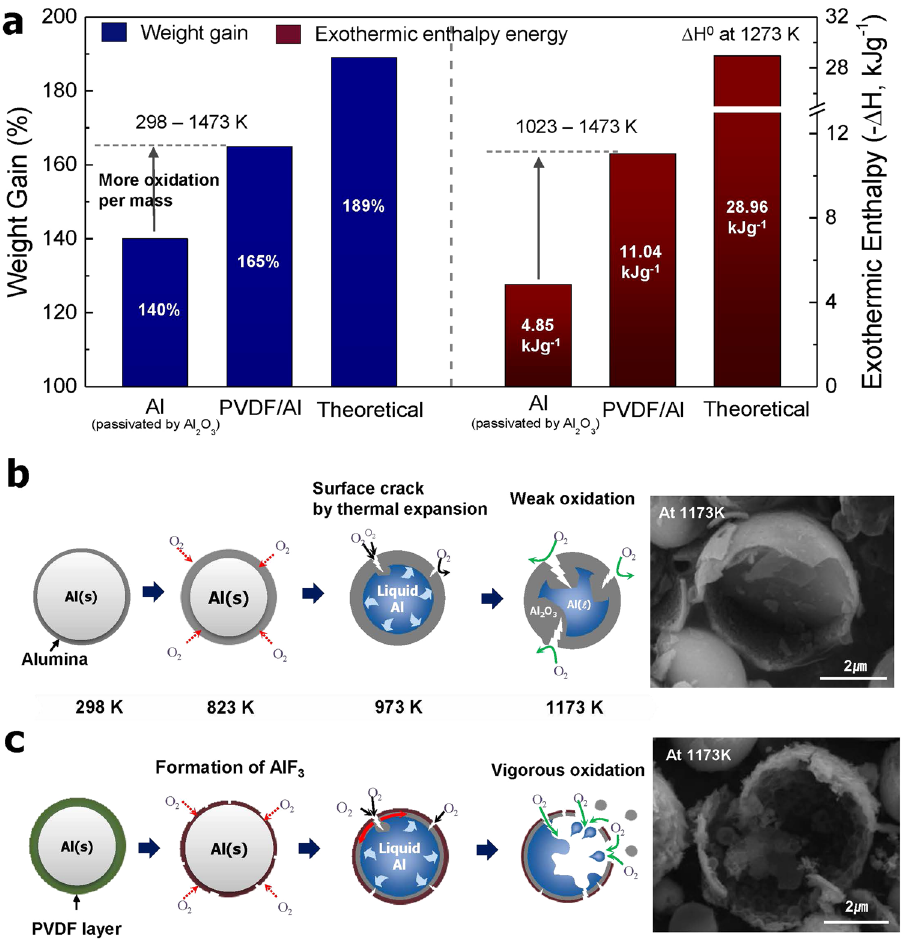
Figure 5. ( a ) Comparison of weight gains and exothermic enthalpy energy levels and a schematic depiction of the proposed oxidation reaction mechanism for ( b ) Al 2 O 3 passivated Al particles and ( c ) PVDF/Al particles with an increase in the